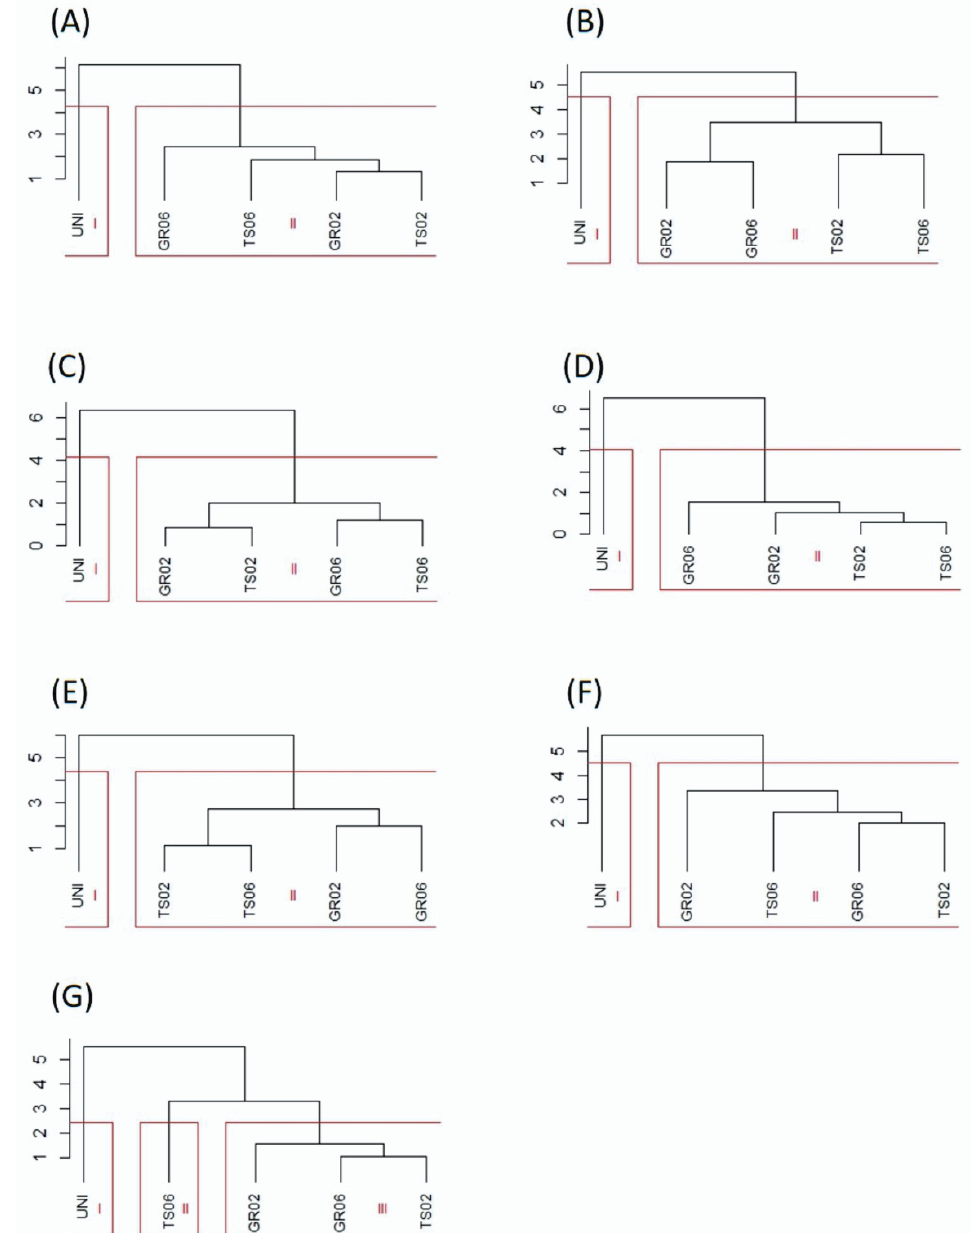
Figure 2. Clustering of treatments with different inoculation methods and doses of Aspergillus niger FS1 in vegetables: ( A ) lettuce, ( B ) melon, ( C ) pepper, ( D ) scarlet eggplant, ( E ) watermelon, ( F ) tomato, and ( G ) kale. The vertical axis represents the dissimilarity (%) between groups. GR02 and GR06: in-furrow granular application at 10 2 and 10 6 conidia plant − 1 , respectively; TS02 and TS06: seed treatment at 10 2 and 10 6 conidia plant − 1 , respectively; UNI: uninoculated control.